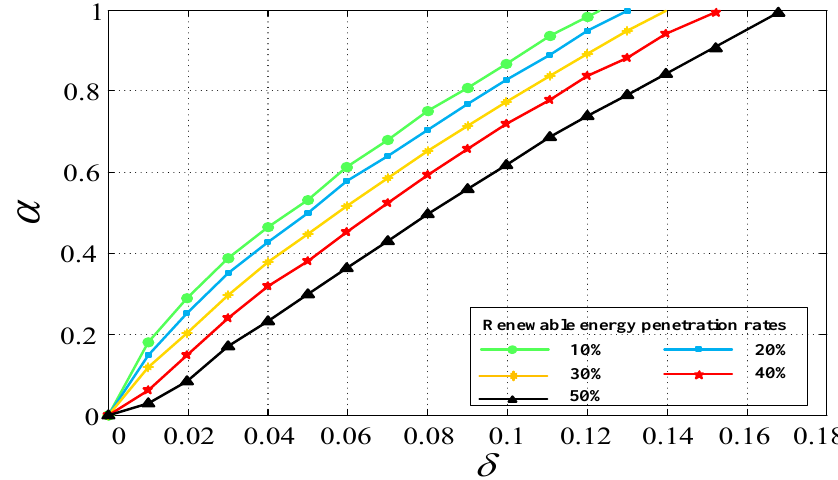
Figure 4. The relationships between the maximum allowance of system uncertainty (MAoSU) and the percentage increase of the minimum preset operational cost.